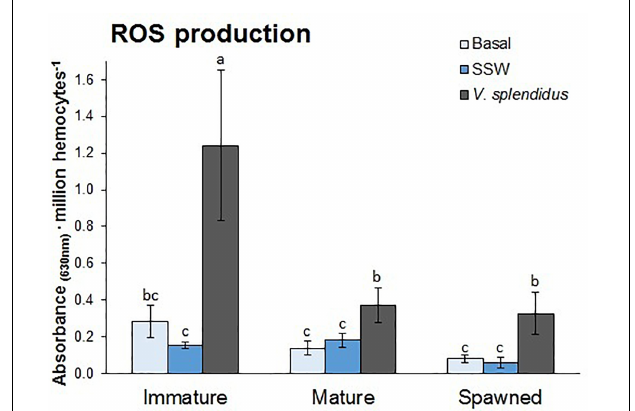
FIGURE 5 | Effects of in vivo challenge with V. splendidus on reactive oxygen species (ROS) formation in hemocytes from immature, mature, and spawned A. purpuratus . Values associated with the same letter belong to the same subset based on a FDR-BY (false discovery rate) post hoc test (Benjamini and Yekutieli, 2001) ( n = 4–8 per condition and treatment).